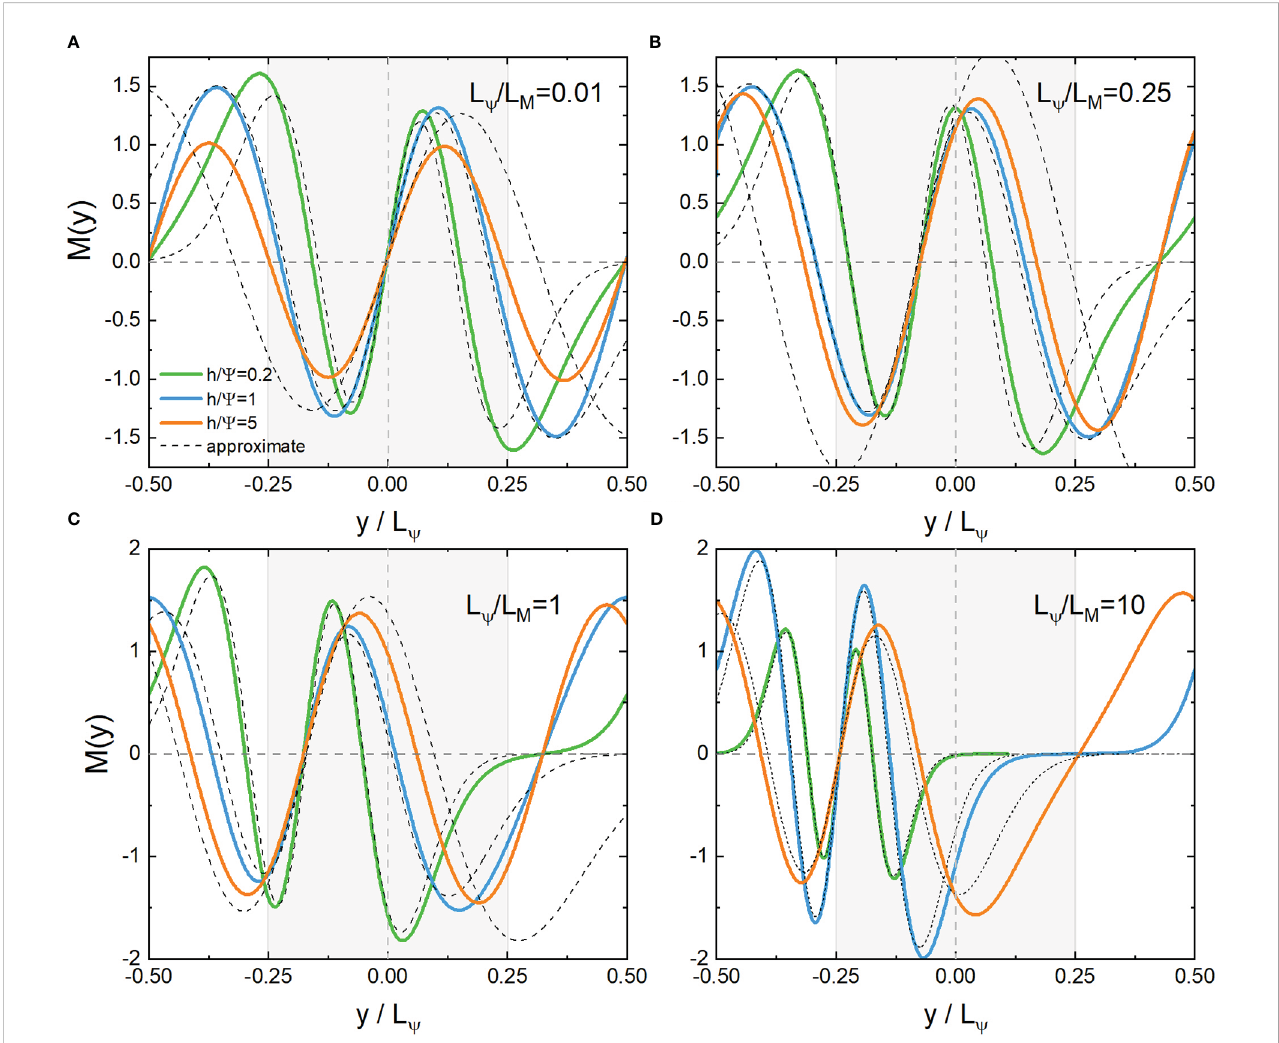
FIGURE 4 Distribution of the odd eigenfunction M S ( w ′ , x , y ′ ) and its approximate solution near the core ( y =0) (A, B) or boundary ( y / L Y = − 1/4) (C, D) with the second lowest eigenvalues. L y / L M = k x / k 0 =0.01,0.25,1,10 , h = Y =